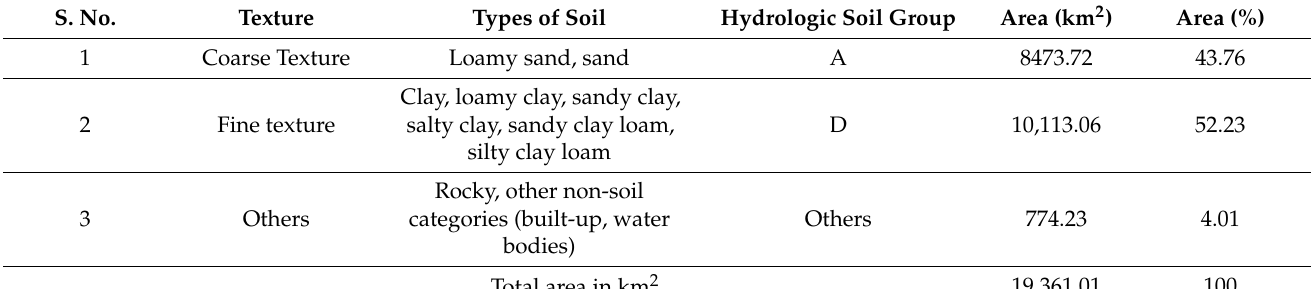
Table 2. Soil texture and types of the study area.